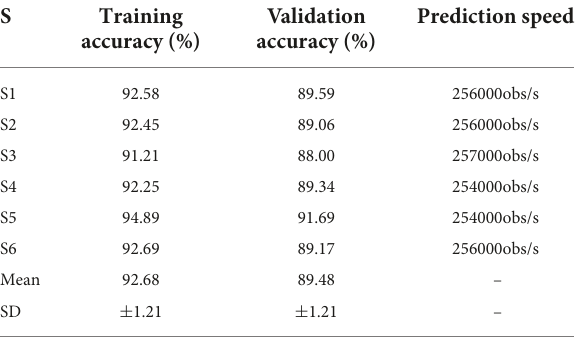
TABLE 12 Offline accuracy of slight-facial expression (sFE)-Net with 10-fold